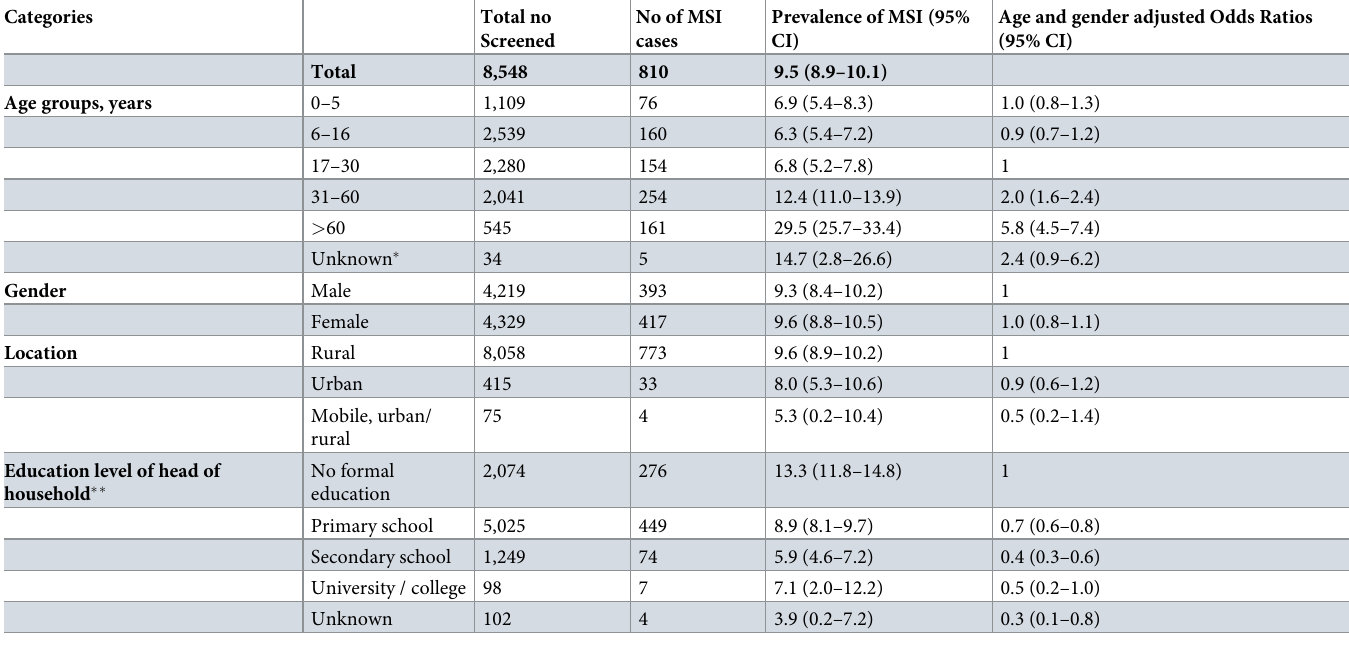
Table 4. Prevalence of MSI by age, gender, location and educational level of head of household.